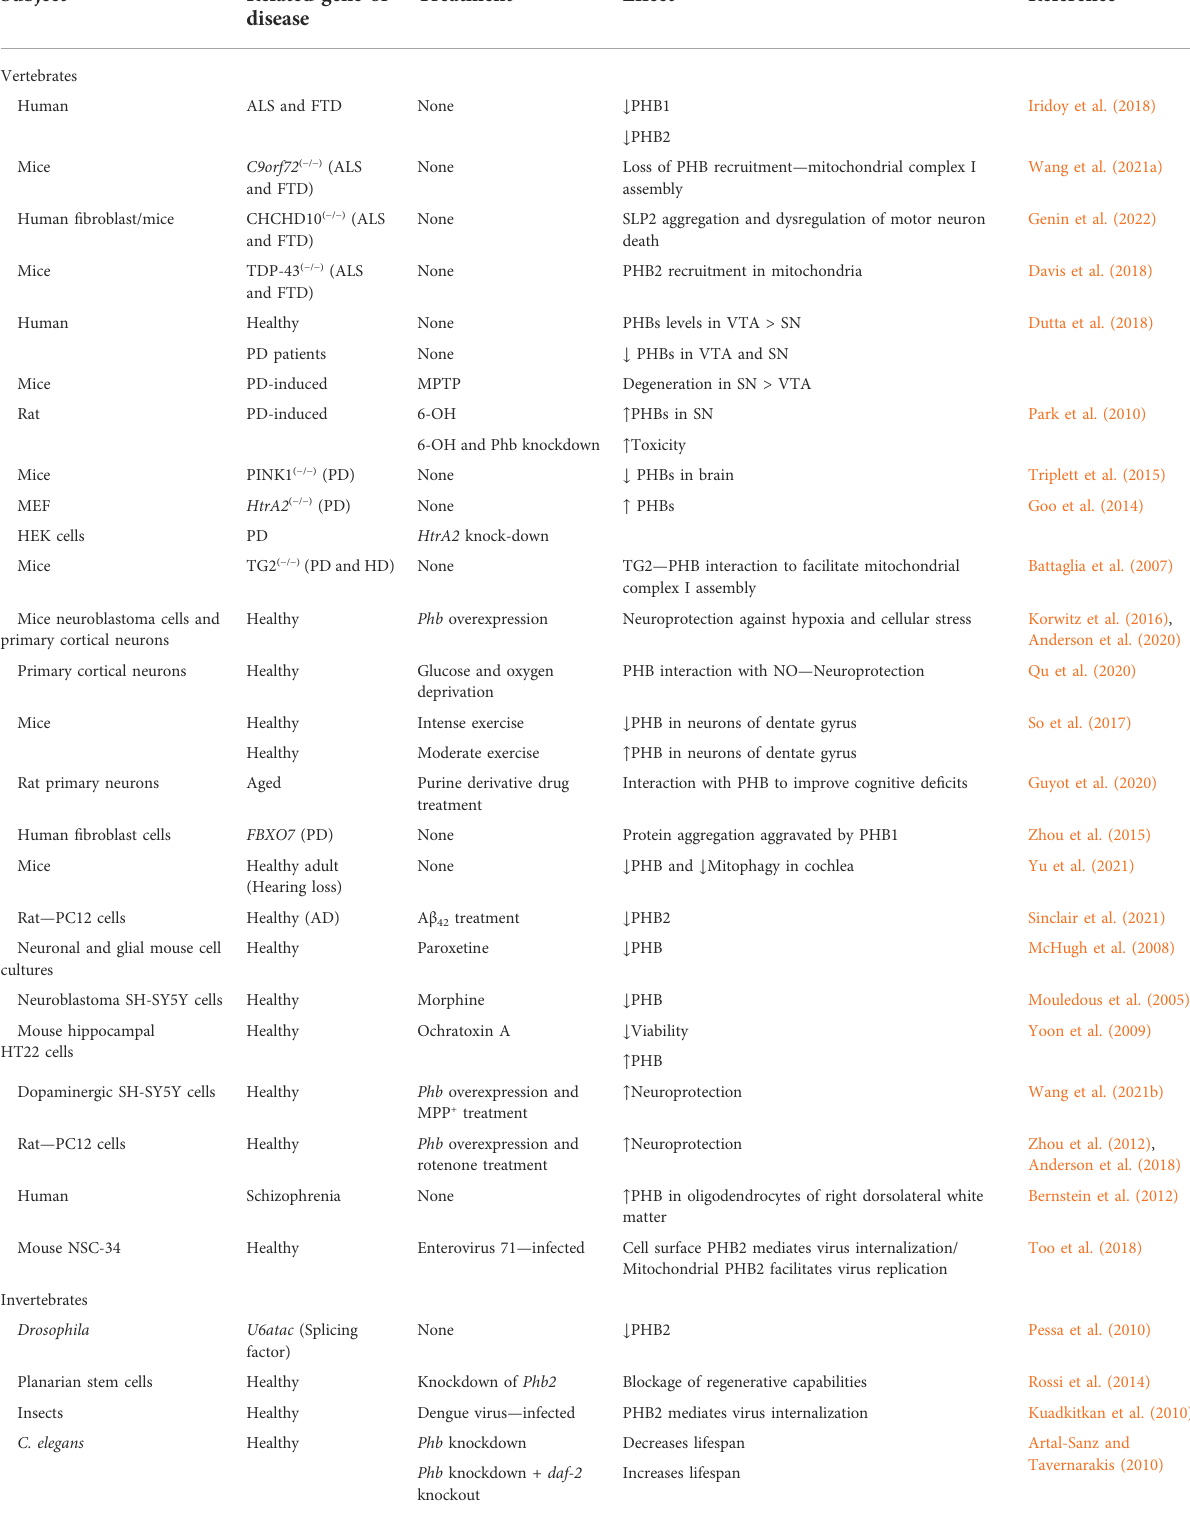
TABLE 1 Summary of the studies involving PHB expression or function in the nervous system, ageing, and